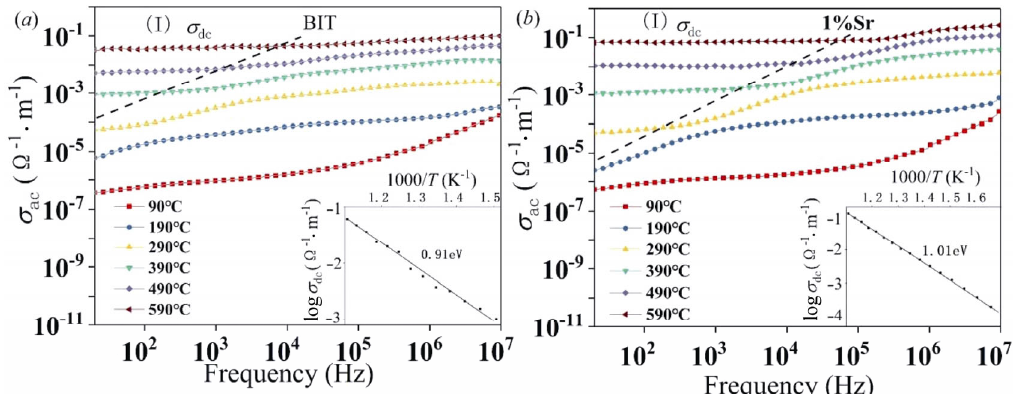
Fig. 6 Frequency dependence of σ ac of (a) BIT and (b) 1%Sr ceramics at different temperatures. The inset shows log σ dc as a function of 10 3 / T